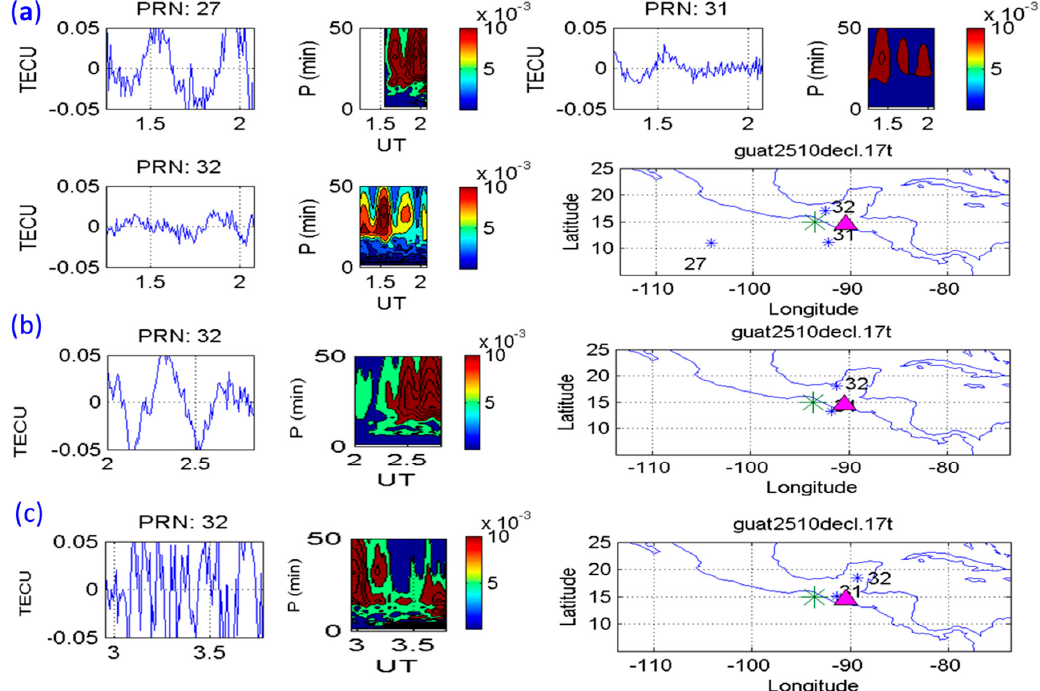
Figure 8. Fluctuations of differential slant TEC obtained from the GUAT station and PRN satellites passing over the earthquake preparation area on 8 September 2017 (DoY 251) at: ( a ) 1.5–2.0 UT (upper 2 panels), ( b ) 2.0–2.5 UT (middle panel) and ( c ) 3.0–3.5 UT (lower panel). Power spectrograms of normalized amplitude are also shown. Maps show earthquake epicenter (green asterisk), GUAT station (pink triangle), number and position of satellite (blue asterisks).